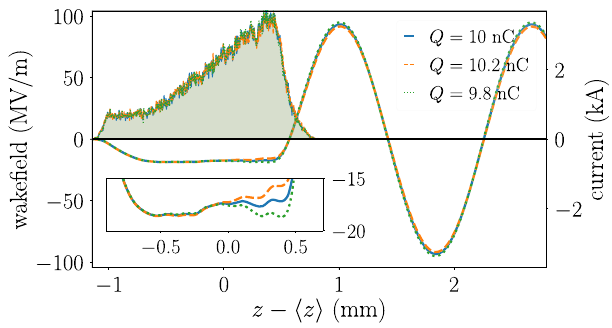
FIG. 20. Current distribution (shaded curves, right axis) and associated wakefields (traces) for the nominal charge and (cid:4) 2% relative change in charge (9.8 and 10.2